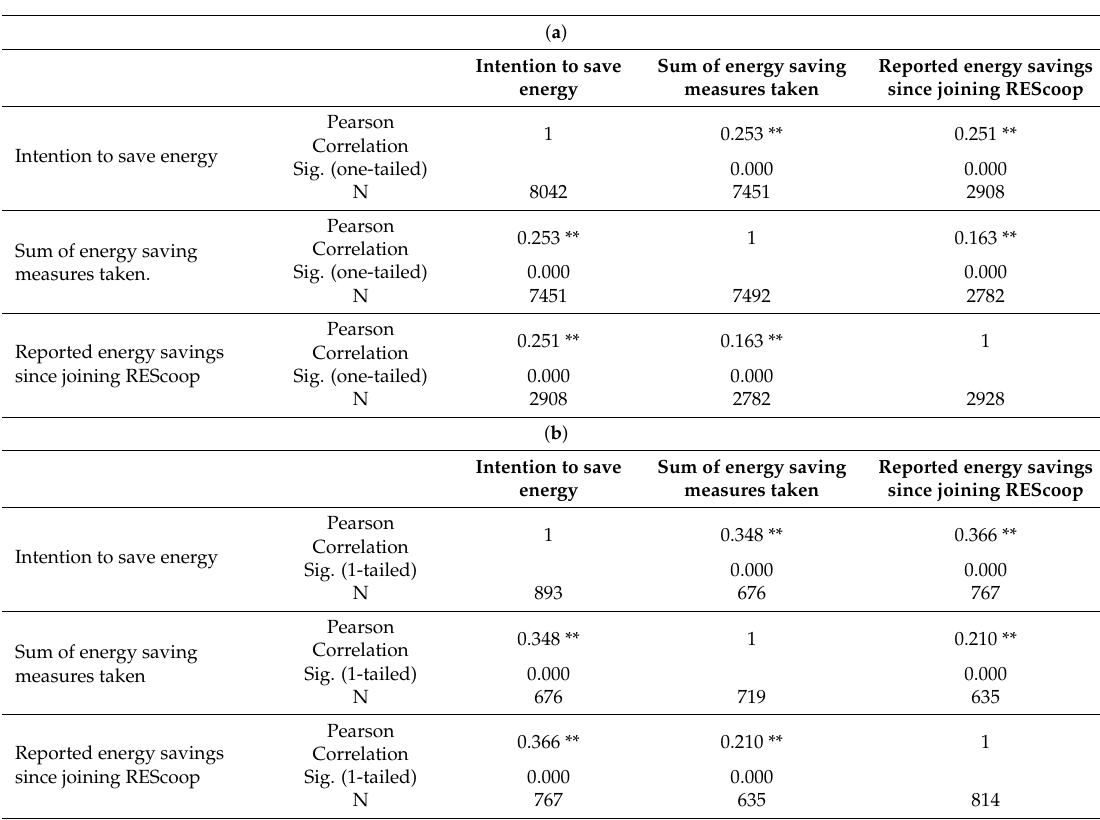
Table A5. ( a ) Enercoop. ( b )